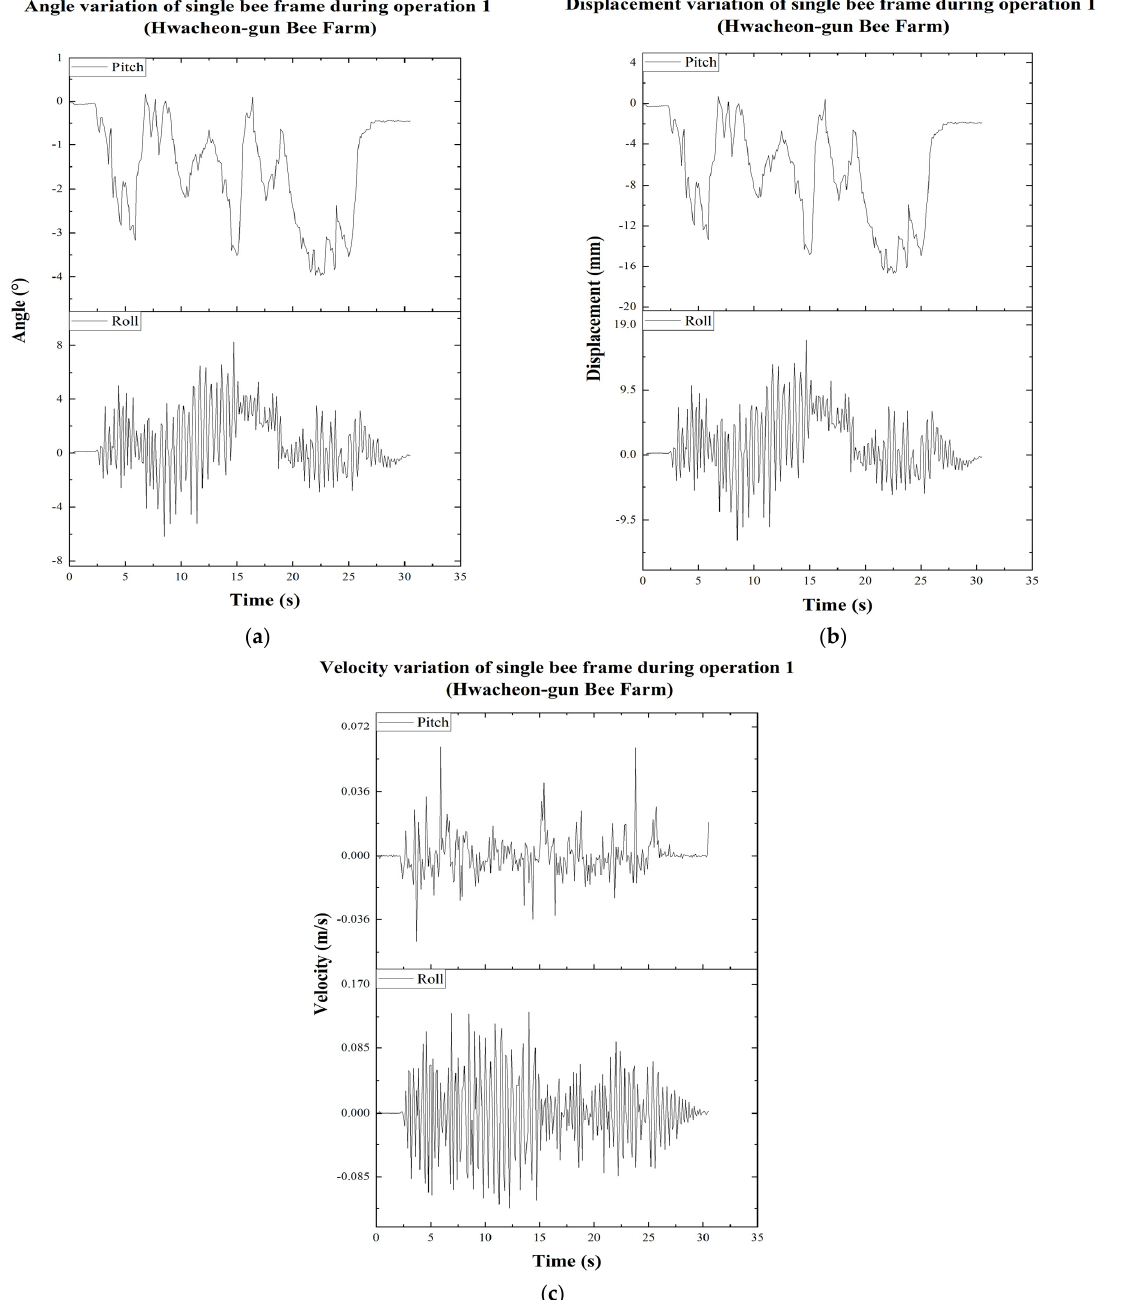
Figure 26. Variation of ( a ) angle, ( b ) displacement, and ( c ) velocity of single bee frame during s-turn transportation.